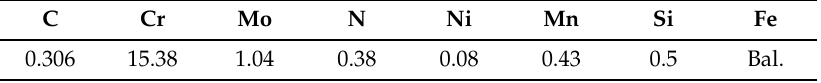
Table 1. Chemical composition of high nitrogen martensitic stainless steel 30Cr15Mo1N (wt.